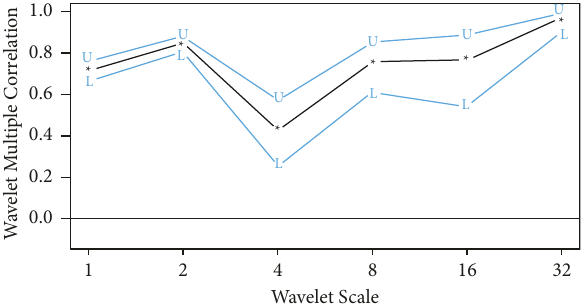
Figure 5: Wavelet bivariate correlations matrix (18/08/2010–03/ 11/2020). The codes for the variables are Argentina (C1), Brazil (C2), Chile (C3), and Columbia (C4).